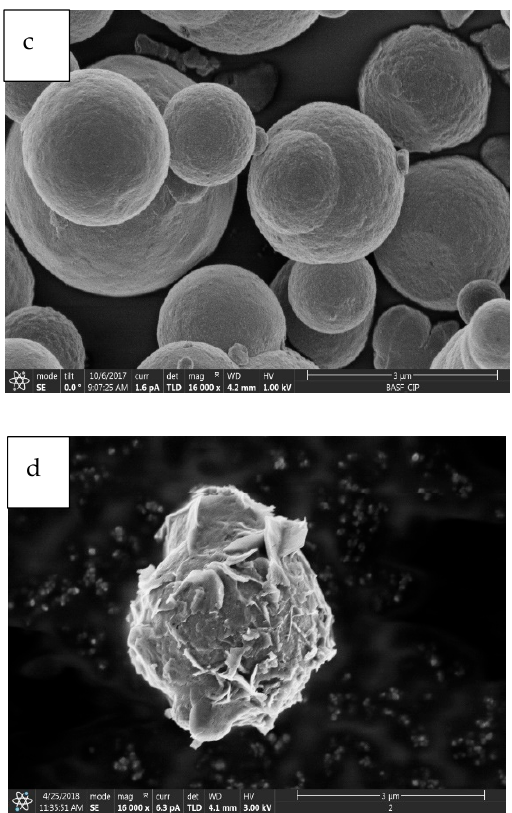
Figure 1. The CIPs samples of ( a ) non-corroded and ( b ) corroded CIPs at magnification of 10,000 × , and ( c ) non-corroded and ( d ) corroded CIPs at magnification of 16,000 × .